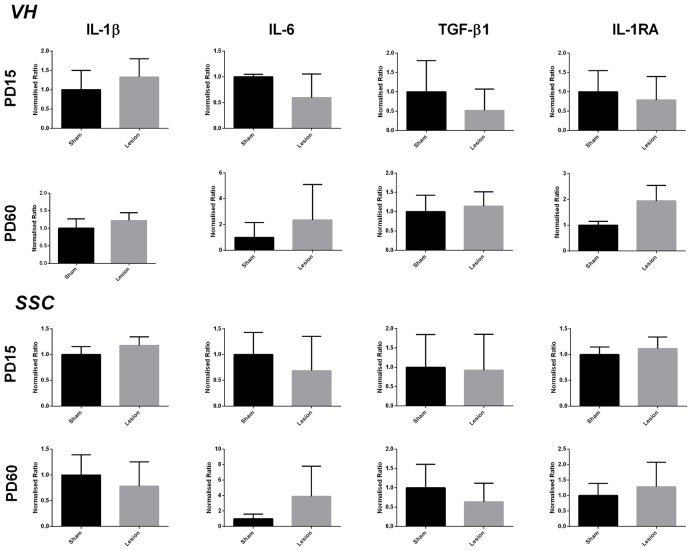
Levels of expression of pro- and anti-inflammatory factors from sham and NVHL animals within VH and somatosensory cortex (SSC) at PD15 and PD60. Quantification of Q-RTPCR data (normalized ratio of gene of interest over housekeeping gene); genes of interest quantified include IL-1β, IL-6, TGF-β1 and IL-1RA at two developmental time points PD15 and PD60. No significant change was observed in the expression of above mentioned genes between sham and lesion at PD15 and PD60 (n = 3–4 per group).